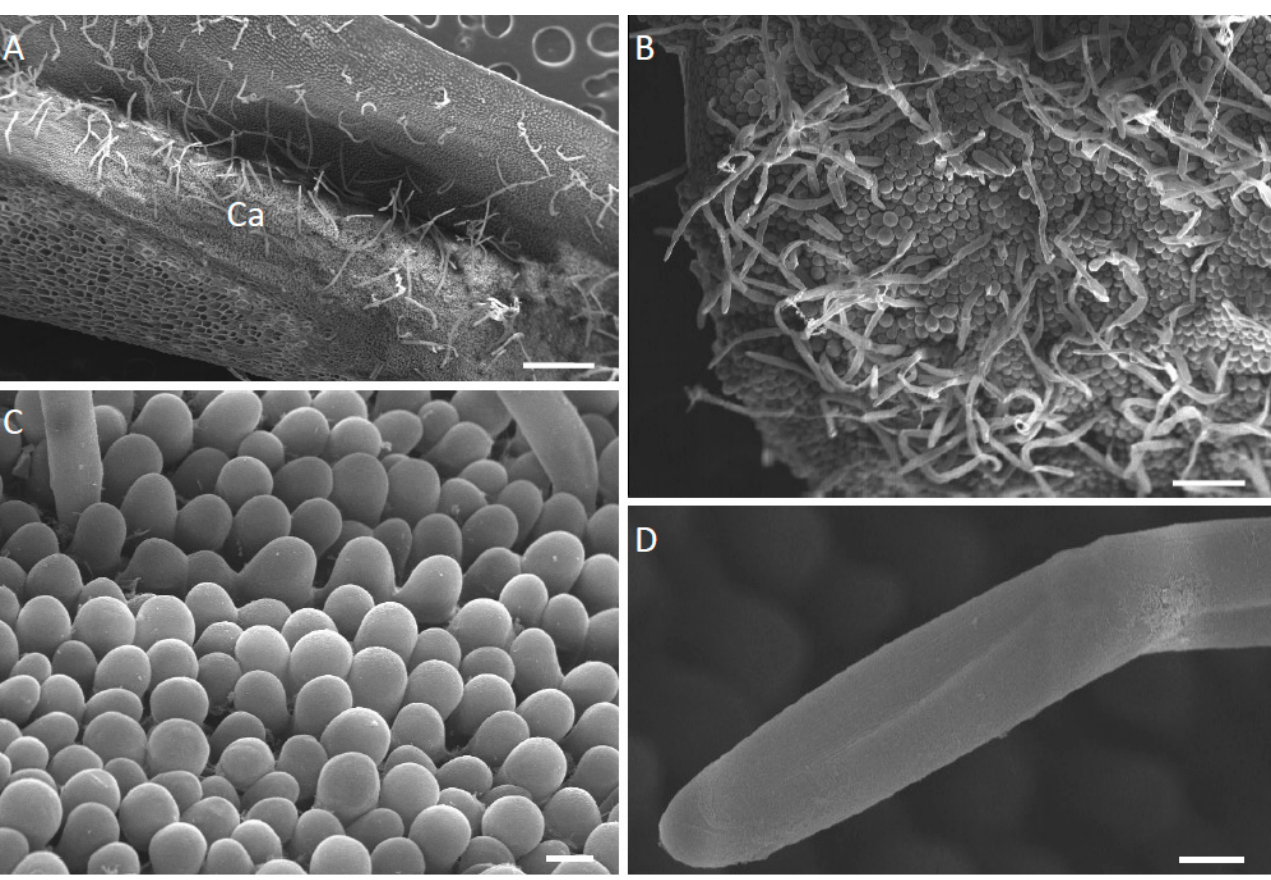
Figure 3. ( A – D ). Adaxial surface of the labellum of M. ochroleuca , SEM. ( A ). Callus and marginal region clothed with trichomes. ( B ). Apical part of labellum with few-celled trichomes and papillose epidermal cells. ( C ). Detail of epidermal papillae with smooth cuticle. ( D ). Detail of apical cell of a trichome. Note the seemingly intact cuticle and the absence of surface secretion. Scale bars = 500 µm, 150 µm, 20 µm, 10 µm, respectively. Ca = callus.